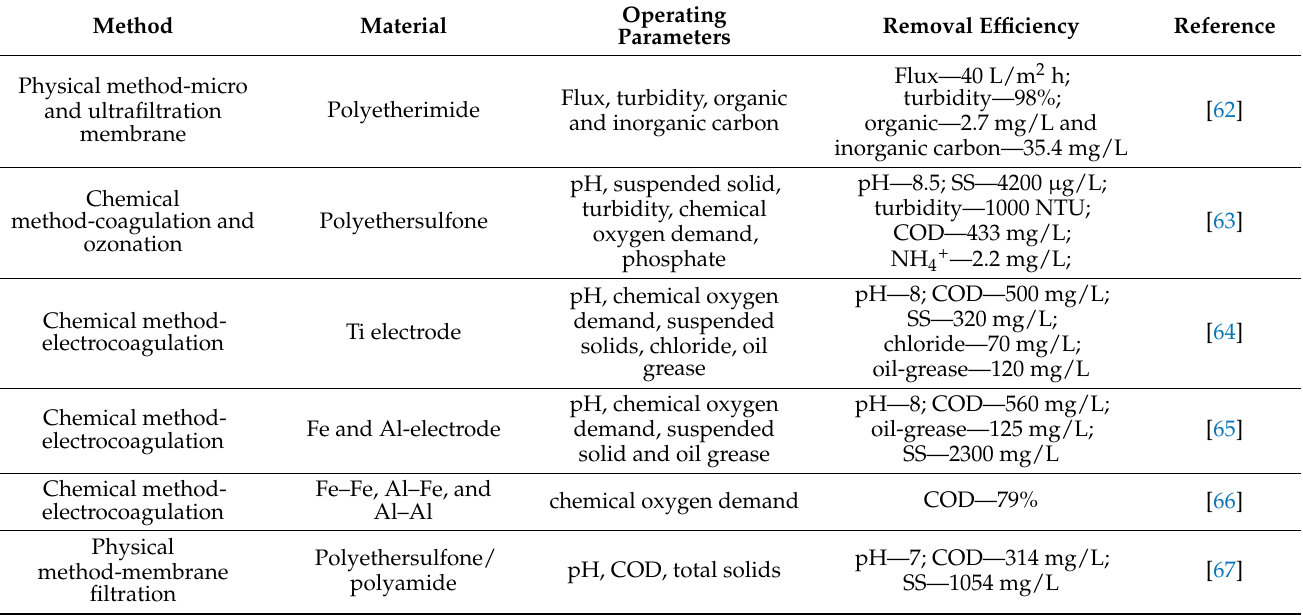
Table 4. Wastewater treatment in the automobile